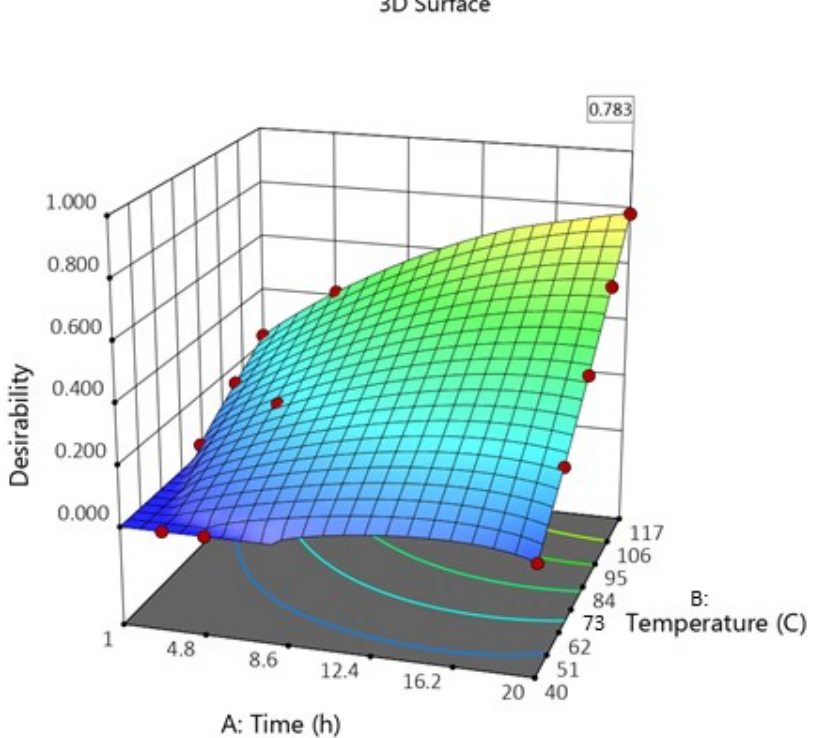
Figure 5. Desirability plot of produced model in terms of time and temperature of delignification tion reaction .